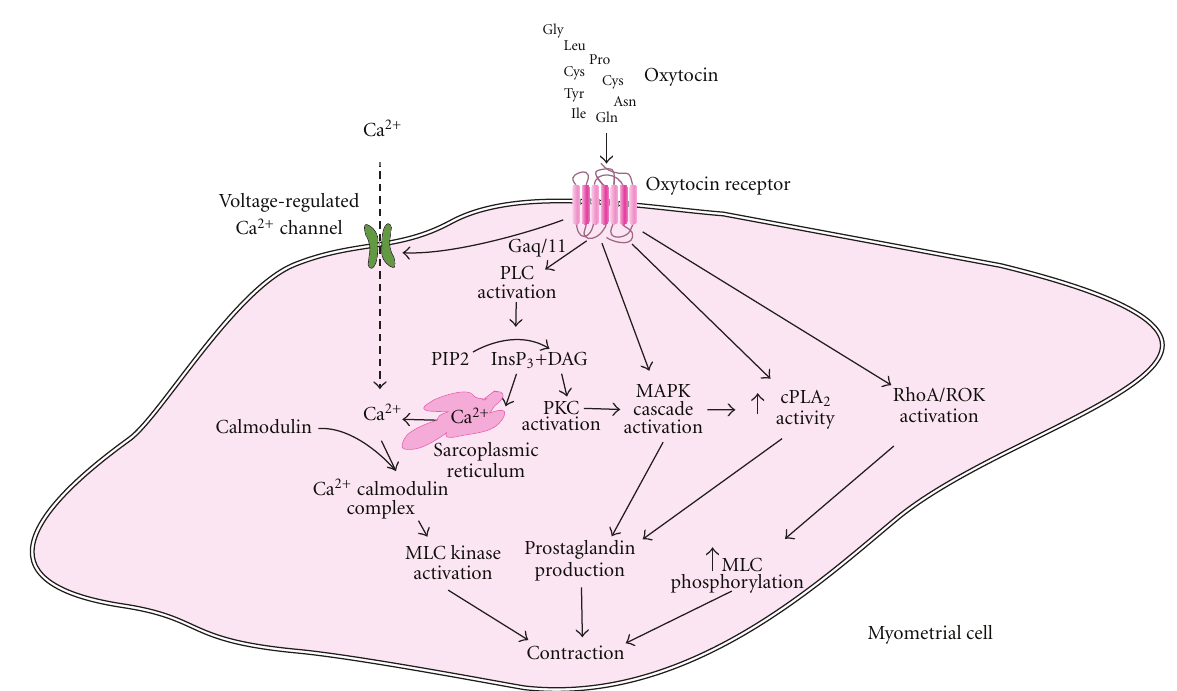
Figure 1: Oxytocin receptor linked signaling pathways resulting in myometrial contraction. Binding of OT to OTR activates G α q / 11 and then PLC, which hydrolyses PIP2 to InsP3 and DAG. InsP3 causes release of Ca 2+ from the sarcoplasmic reticulum, while DAG activates PKC. G α q / 11 also causes activation of voltage-regulated Ca 2+ channels and Ca 2+ entry into the cells. Ca 2+ binds to calmodulin, and the Ca 2+ - calmodulin complex activates MLC kinase, resulting in myometrial contraction. Both OTR and PKC activate the MAPK cascade, while OTR and MAPK result in increased cPLA2 activity. Increased cPLA2 activity and MAPK activation result in prostaglandin production, which also contributes to the contractile e ff ect. The activation of the RhoA-ROK cascade by the OTR is another pathway that results in increased MLC phosphorylation and myometrial contraction. OT: oxytocin, OTR: oxytocin receptor, PLC: phospholipase, PIP2: phosphatidylinositol 4,5-bisphosphate, InsP3: inositol 1,4,5- triphosphate, DAG: diacylglycerol, PKC: protein kinases type C, MLC: myosin light-chain,